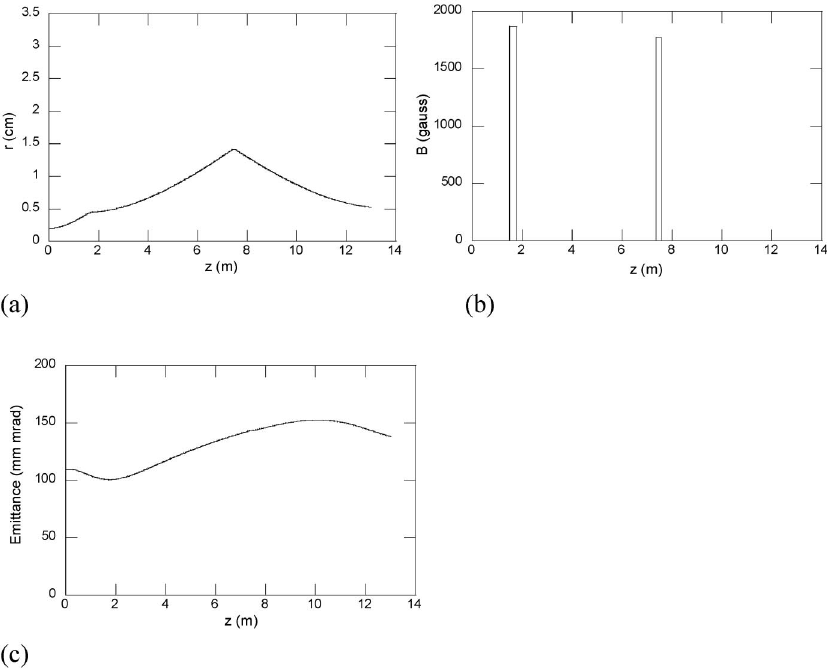
FIG. 30. Downstream tune: (a) rms beam radius evolution, (b) applied external magnetic field, and (c) rms beam emittance